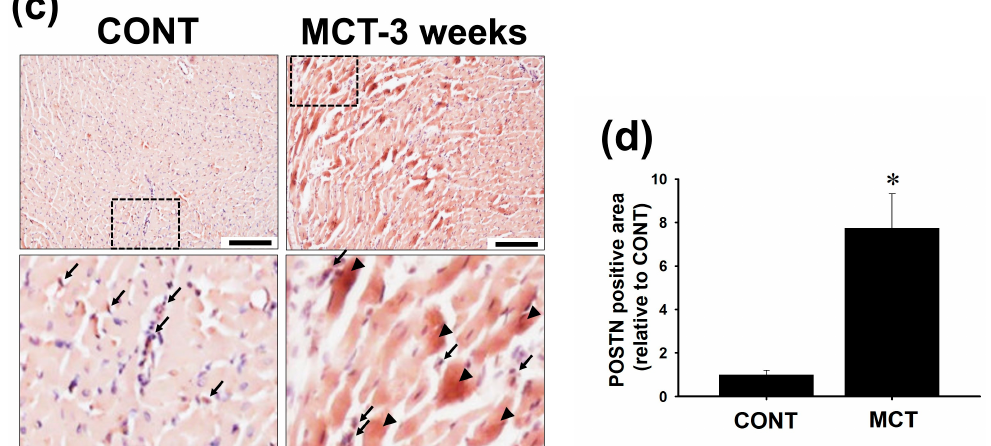
Figure 1. Protein expression of periostin (POSTN) was increased in right ventricles (RVs) of monocrotaline (MCT, 3 weeks)-injected rats. Expression of POSTN in RV tissues of MCT (2 weeks: n = 5; 3 weeks: n = 6)- or saline-injected (CONT, 2 weeks: n = 5; 3 weeks: n = 4) rats was evaluated by western blotting. ( a ) Representative blots were shown (upper: 2 weeks; lower: 3 weeks). ( b ) POSTN expression level was corrected by glyceraldehyde-3-phosphate dehydrogenase (GAPDH), and the normalized expressions relative to CONT were shown as mean ± standard error of the mean (S.E.M.). ( c ) The expression and distribution of POSTN in RVs of CONT and MCT (3 weeks)-injected rats was evaluated by immunohistochemical staining. Representative images for RVs from CONT (left) and MCT (3 weeks)-injected (right) rats were shown. Enlarged views of boxed regions in the upper original images were shown (3.8-fold magnification). Arrows indicate POSTN-positive interstitial cells. Arrowheads indicate POSTN-positive cardiomyocytes. ( d ) The ratio of POSTN-positive area to total RV area was calculated, and the normalized ratio relative to CONT was shown as mean ± S.E.M. ( n = 3). Scale: 100 μ m. * p < 0.05 versus CONT.